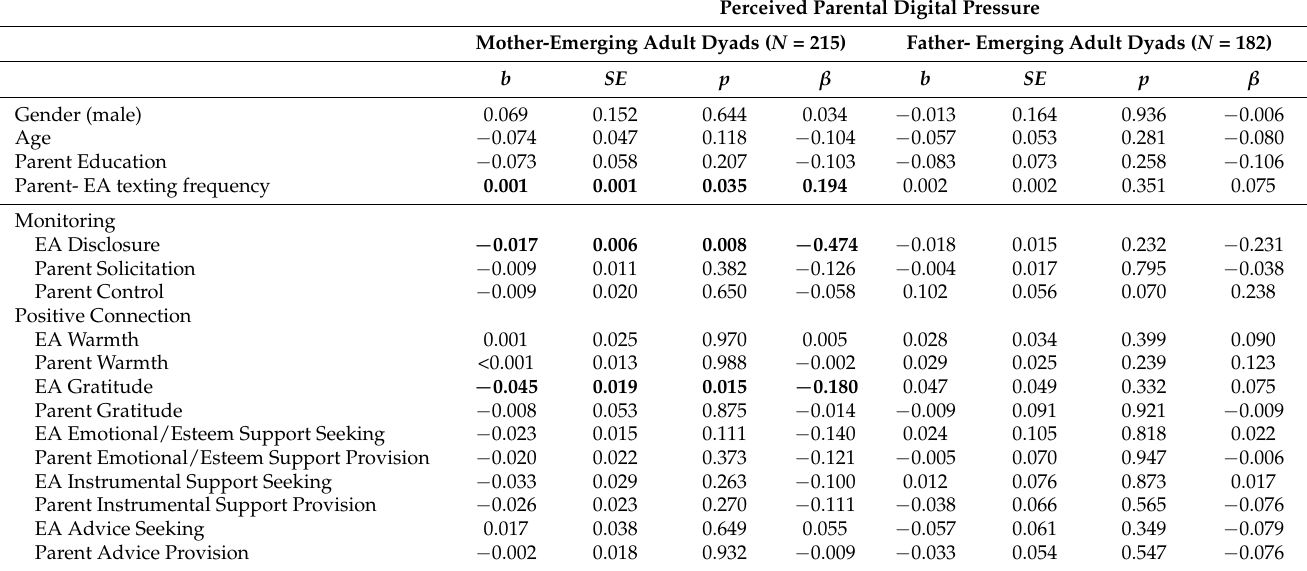
Table 4. Associations between Parent-Emerging Adult Texting Frequency and Content Codes with Emerging Adult Perceived Parental Digital